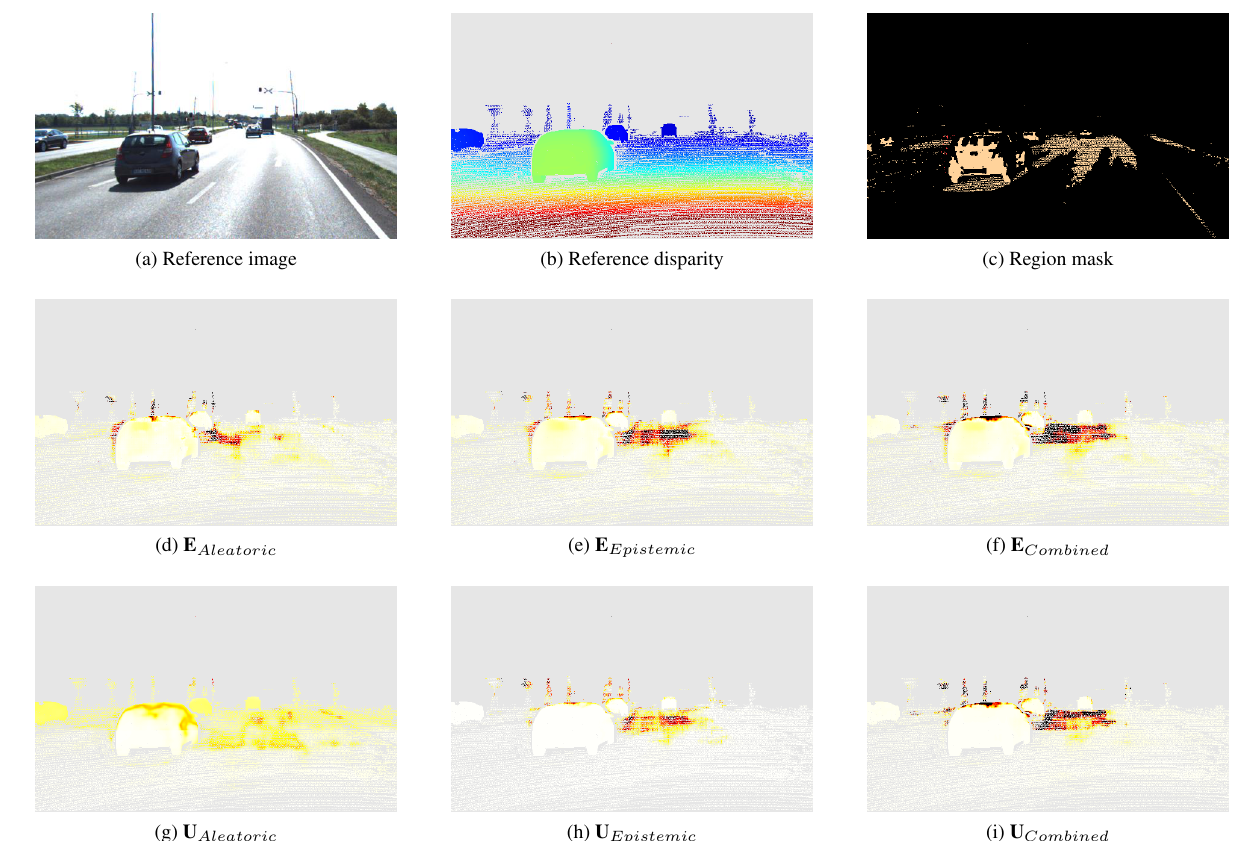
Figure 4. Qualitative comparison of different variants of the method proposed on an example of the KITTI dataset. The figure shows the absolute disparity error maps E in comparison to the associated uncertainty maps U of the three variants that estimate aleatoric, epistemic and both kinds of uncertainty together, respectively. For an explanation of the colour coding, refer to Figure